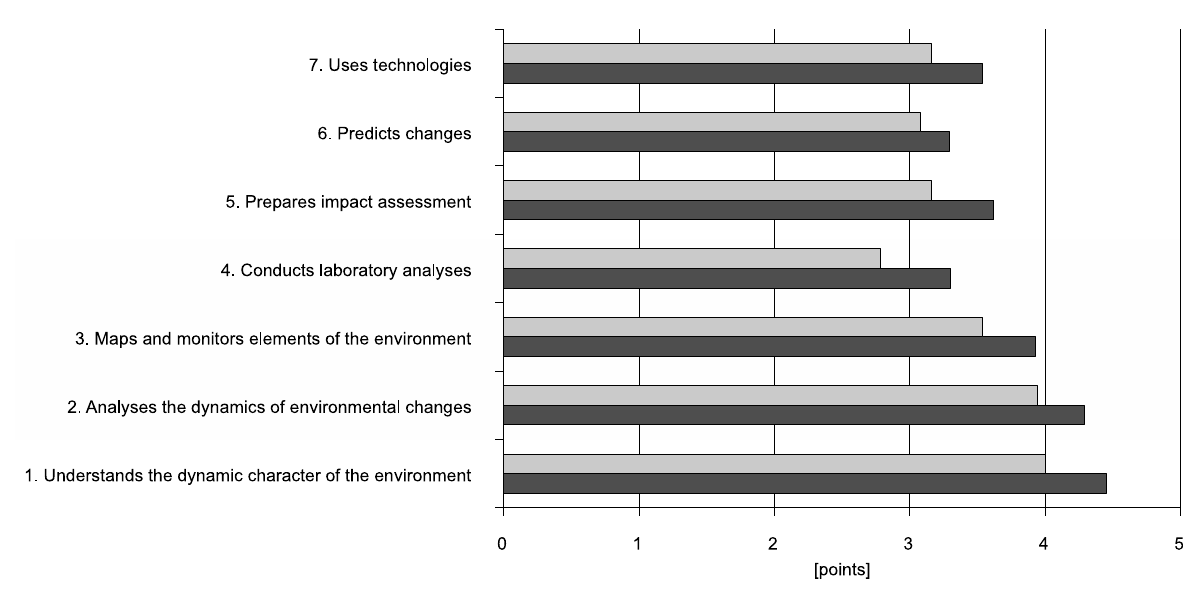
Fig. 1. Assessment of the level of professional qualifications (general-geographical) of the students of the last year of master’s studies.